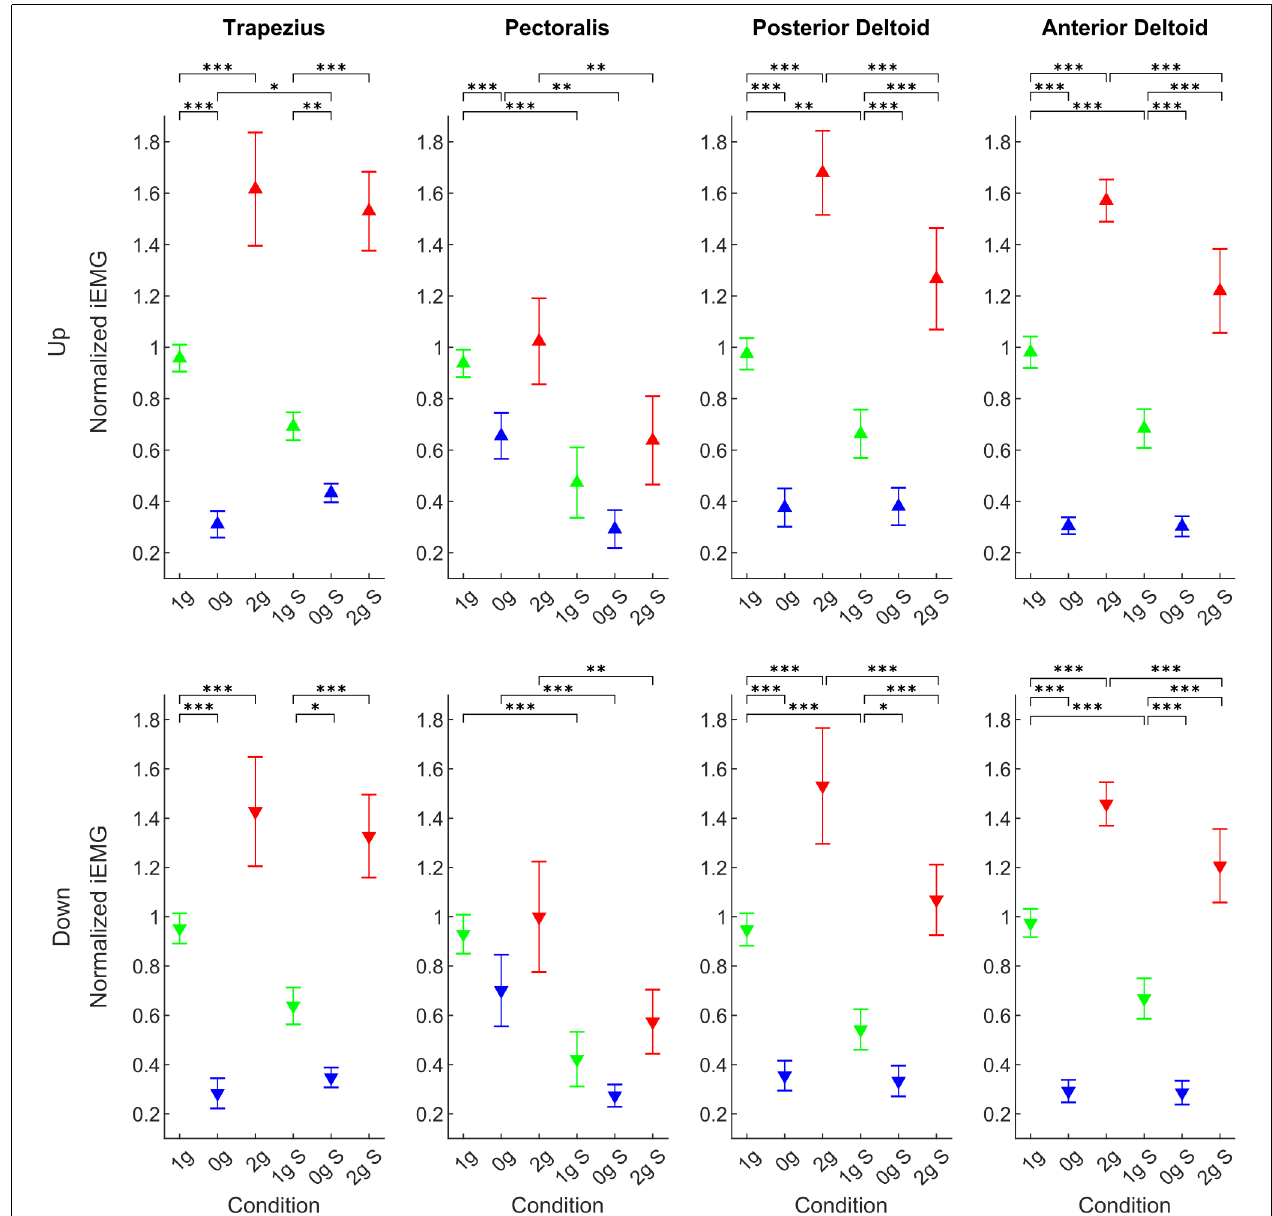
FIGURE 9 | Normalized integrated EMG for the Trapezius, Pectoralis, Anterior Deltoid, and Posterior Deltoid for all conditions. Downward-pointing triangles denote mean values for downward movements, upward-pointing triangles denote mean values for upward movements, the whiskers denote the standard error of the mean. Green represents normogravity, blue represents microgravity and red represents hypergravity conditions, (1g, 0g, 2g) denote in-flight gravitational conditions, (1g S, 0g S, 2g S) denote simulated gravitational conditions. ∗ p < 0.05, ∗∗ p < 0.01, ∗∗∗ p < 0.001. × simulation for the Trapezius ( F (2,246) = 4.55, p = 0.011), Anterior Deltoid ( F (2,246) = 11.13, p < 0.001) and Posterior Deltoid ( F (2,246) = 9.93, p < 0.001), while there was no significant effect at the Pectoralis muscle ( F (2,246) = 0.31, p = 0.730). Post hoc test results of the different conditions are presented in Table 6 . For the upward direction, the effects were exactly the same. We found a significant main effect of gravity for the Trapezius ( F (2,244) = 274.77, p < 0.001), Pectoralis ( F (2,244) =